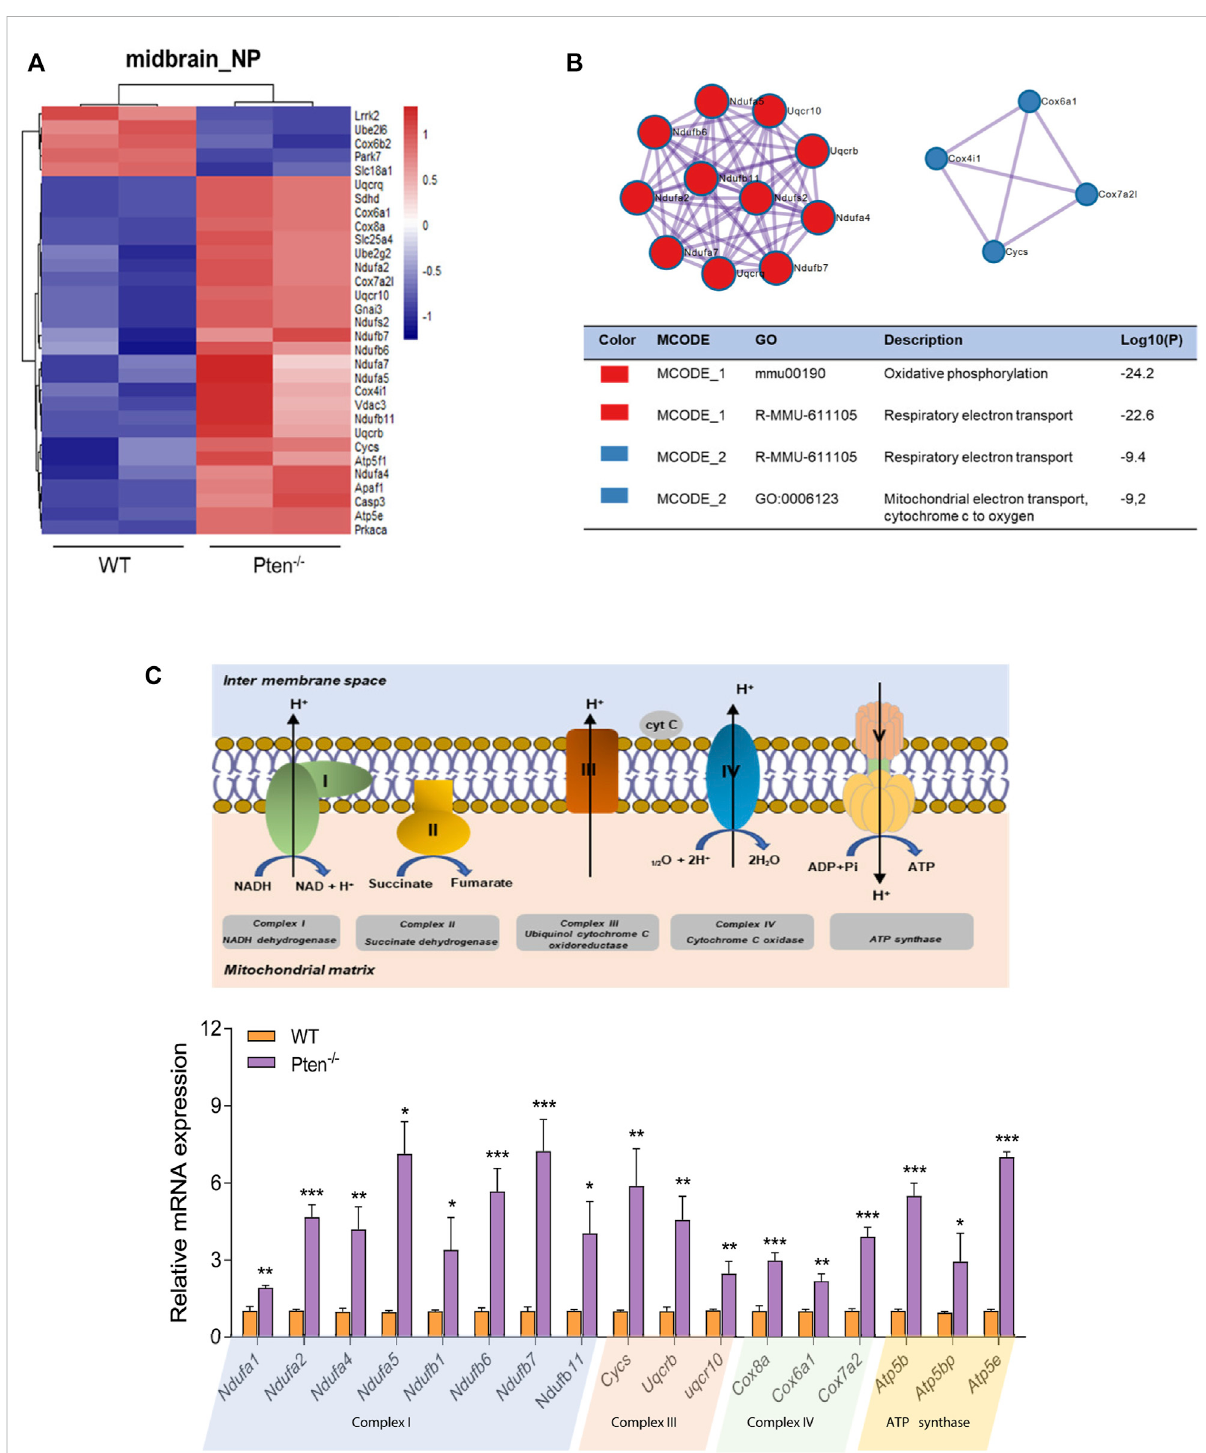
FIGURE 6 Pten disruptedmidbraindifferentiationthroughregulatingmitochondrialfunction. (A) Heatmapofmitochondrialassociated geneschangedby thelossofPteninmidbrainprogenitorcells. (B) PathwaysenrichedbyMetascapeanalysisofDEGsinvolvedinmitochondrialfunction. (C) ThemRNA expression levels of genes involved in the mitochondrial respiratory chain. * p < 0.05, ** p < 0.01, and *** p < 0.001.